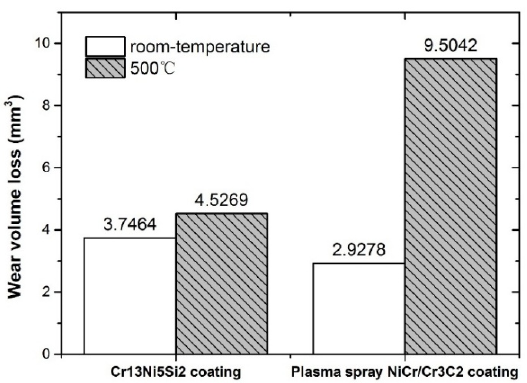
Figure 13. Wear volume loss of the Cr 13 Ni 5 Si 2 -based composite coating and the plasma spray NiCr/Cr 3 C 2 coating at room temperature and at 500 °C.